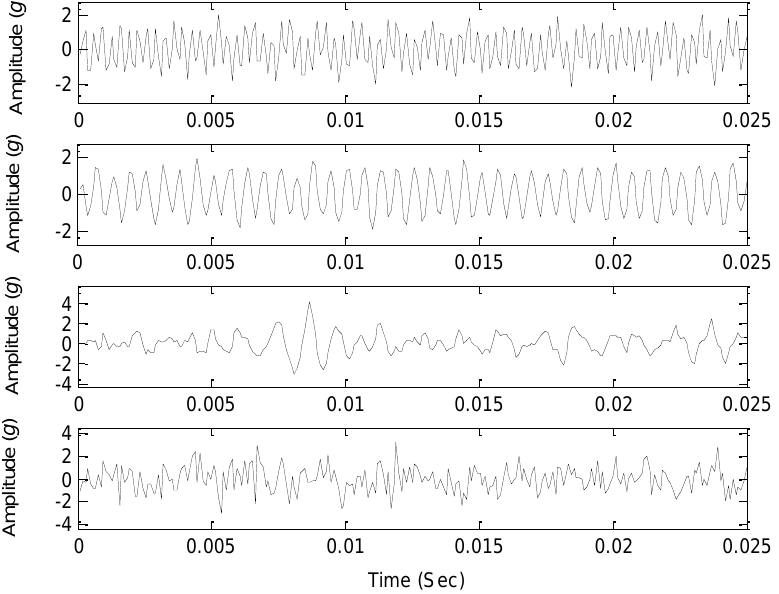
Figure 14. The waveforms of the separated components by fast ICA